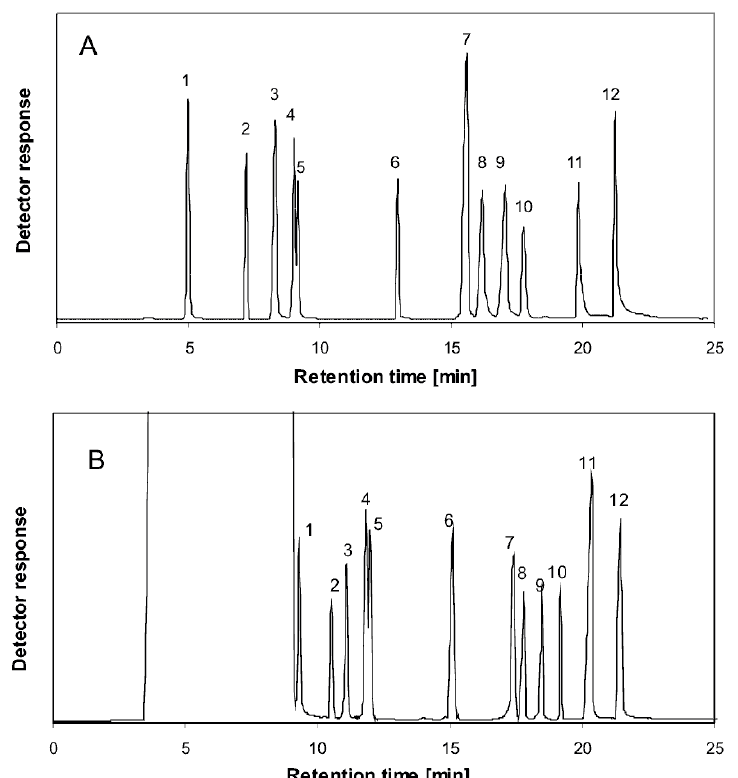
Figure 3. GC-FID chromatograms of standard mixture of analysed essential oils after SPME (A) and SDME (B) extraction step. 1 - α -pinene, 2 – myrcene, 3 – 1,4-cineole, 4 – eucalyptol, 5 - limonene, 6 – α -thujone, 7 – camphor, 8 - menthone, 9 – borneol, 10 – menthol,